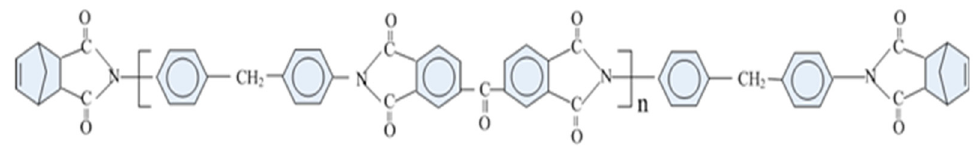
Figure 1. The chemical structure of polyimide resin.